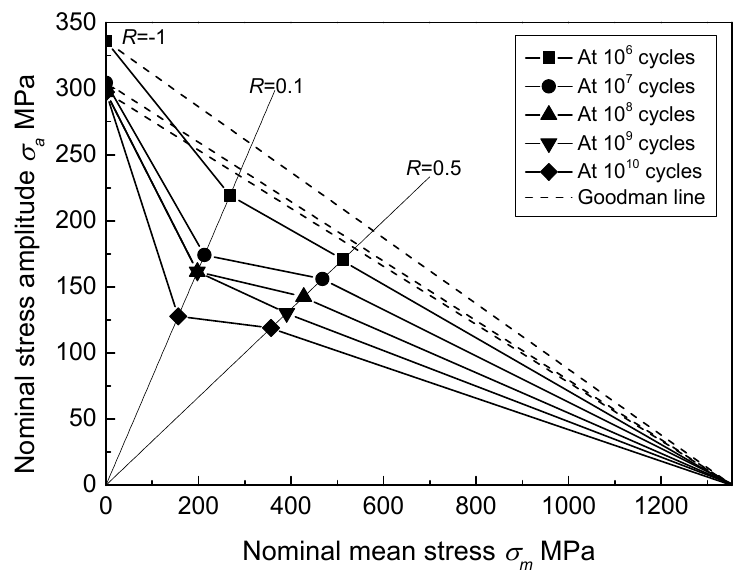
Figure 9. Haigh diagram of the notched specimen at different fatigue life.